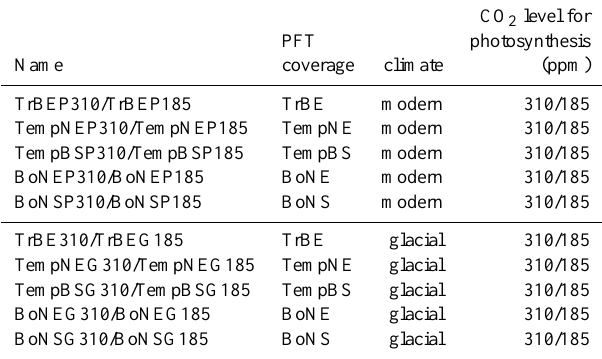
Table 3. Names and characteristics of the static runs. Abbrevations for PFT coverage: see Table